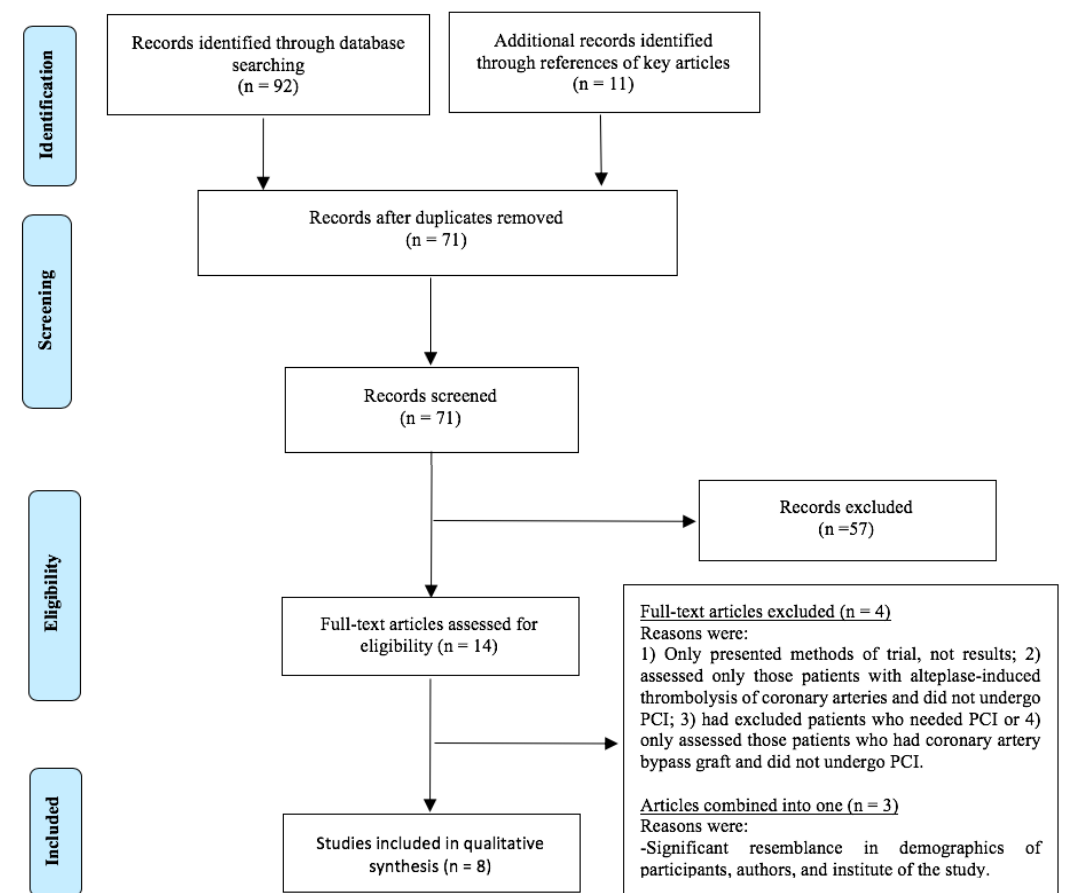
Figure 1. Preferred Reporting Items for Systematic Reviews and Meta-Analyses (PRISMA) Flow Diagram. The numbers document the literature search results.